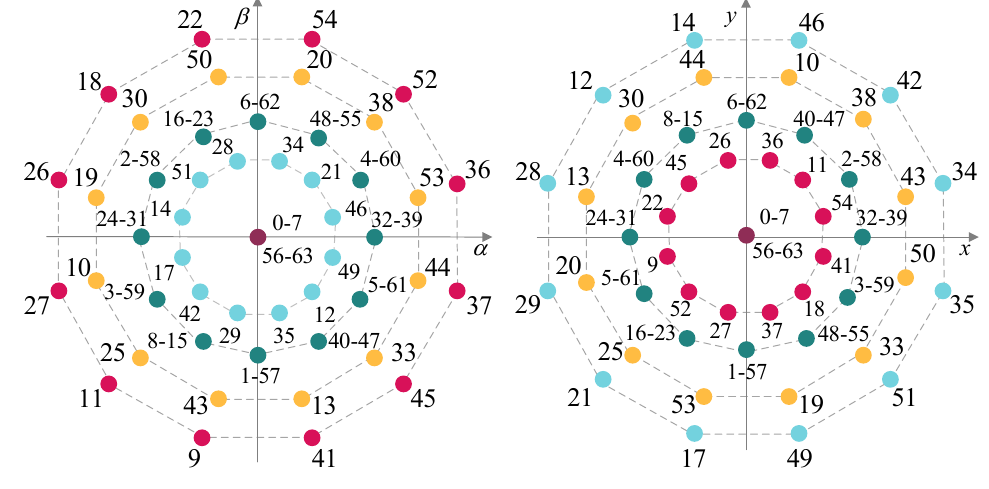
Figure 2. Voltage vectors in α - β and x - y